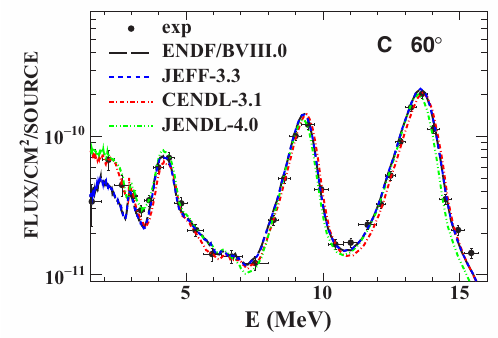
Figure 4. Neutron leakage spectra for C sample at 60 ◦ .